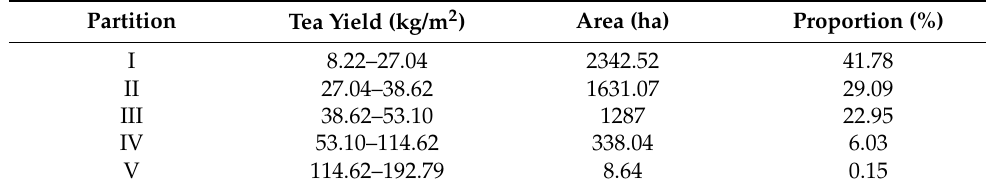
Table 7. Statistics on the reclassified areas of the tea gardens in Fuzhou.